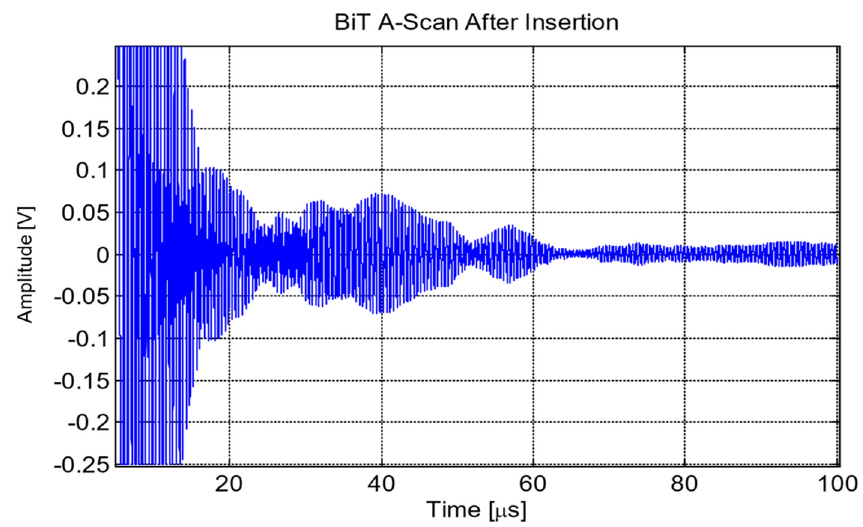
Figure 11. Bismuth titanate (BiTi) A-scan measured directly after insertion [14].